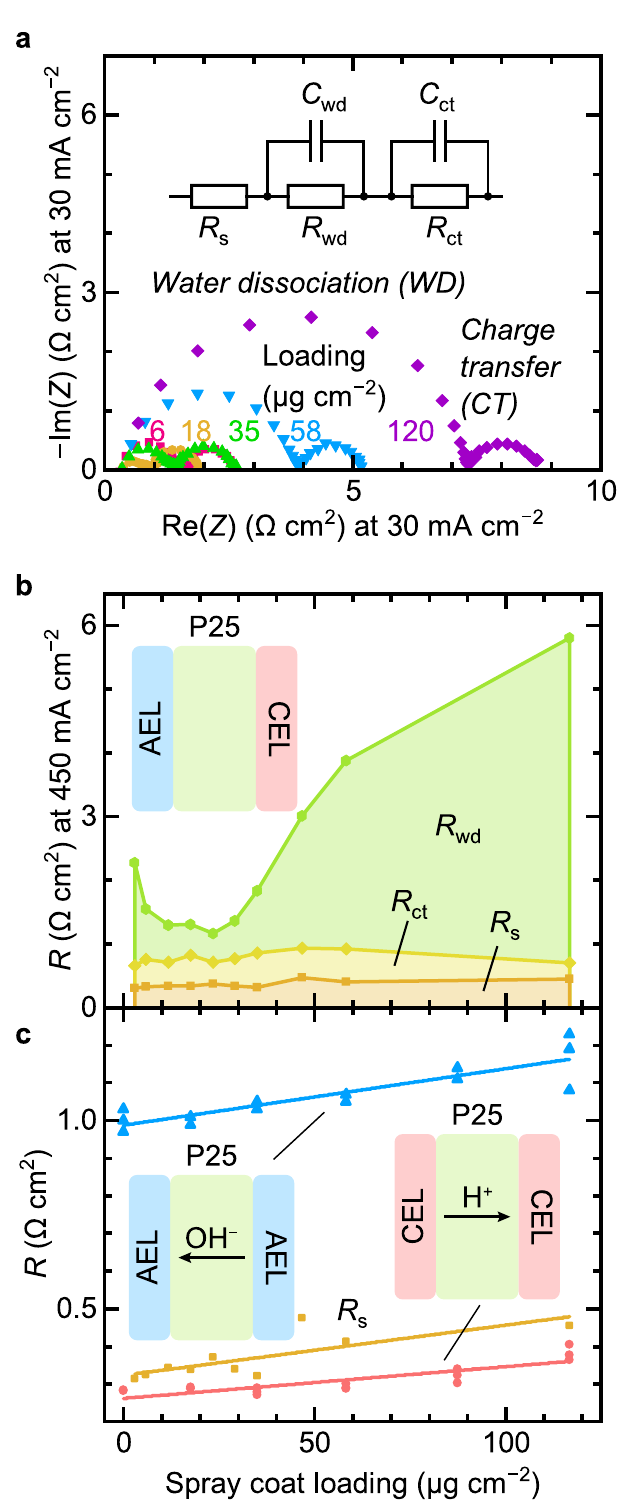
Fig. 5 Impedance analysis of BPM electrolyzers. a Nyquist plots of BPM electrolyzers at 30 mA cm − 2 with different loadings of TiO 2 -P25 deposited by spray coating WD catalysts. The high frequency semicircle is assigned to WD, while the low frequency one to charge transfer. The inset shows the equivalent circuit used to fi t the EIS data. b Extracted resistance values at 450 mA cm − 2 as a function of TiO 2 -P25 loading. c Comparison of series resistance R s (orange) extracted from BPM electrolyzer EIS data at 450 mA cm − 2 with the resistance of PEM (red) and AEM (blue) electrolyzers at 300 – 500 mA cm − 2 as a function of TiO 2 -P25